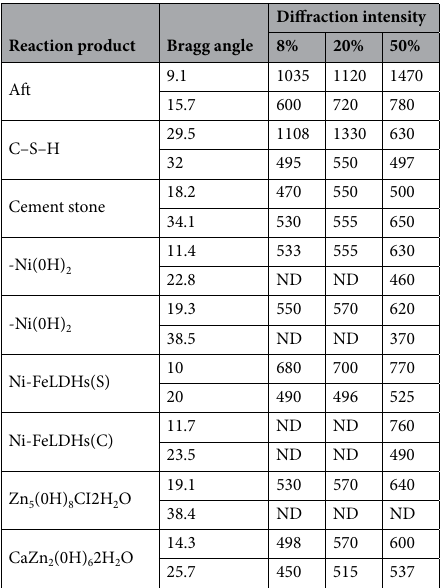
Table 6. Diffraction peak intensities of products in cured soil with different BCP contents after curing for 28